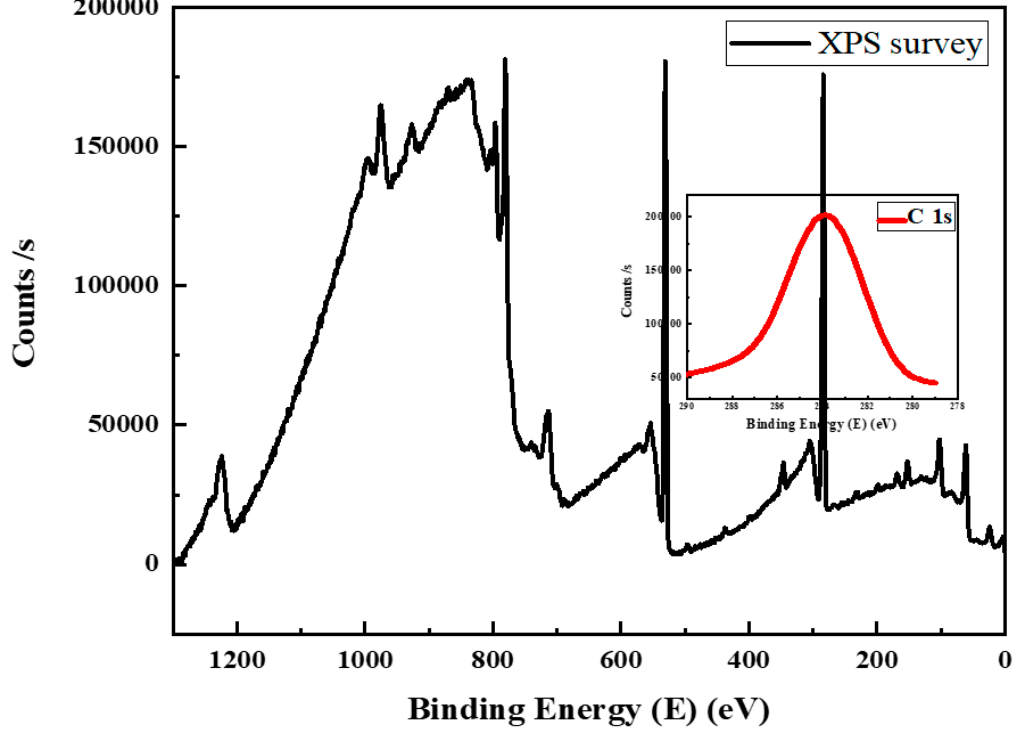
Figure 10. XPS studies of the deactivated catalysts after 60 h of time on stream in silicon microchannel microreactor.